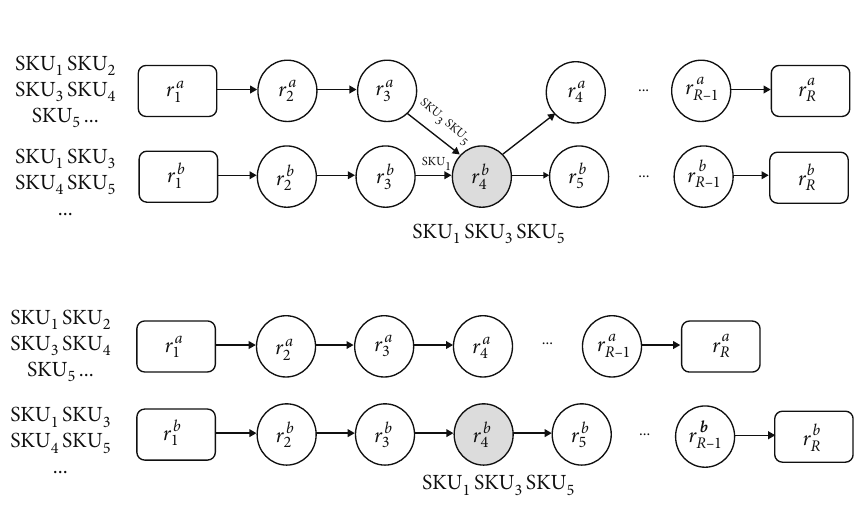
Figure 4: Inter-shift operator.